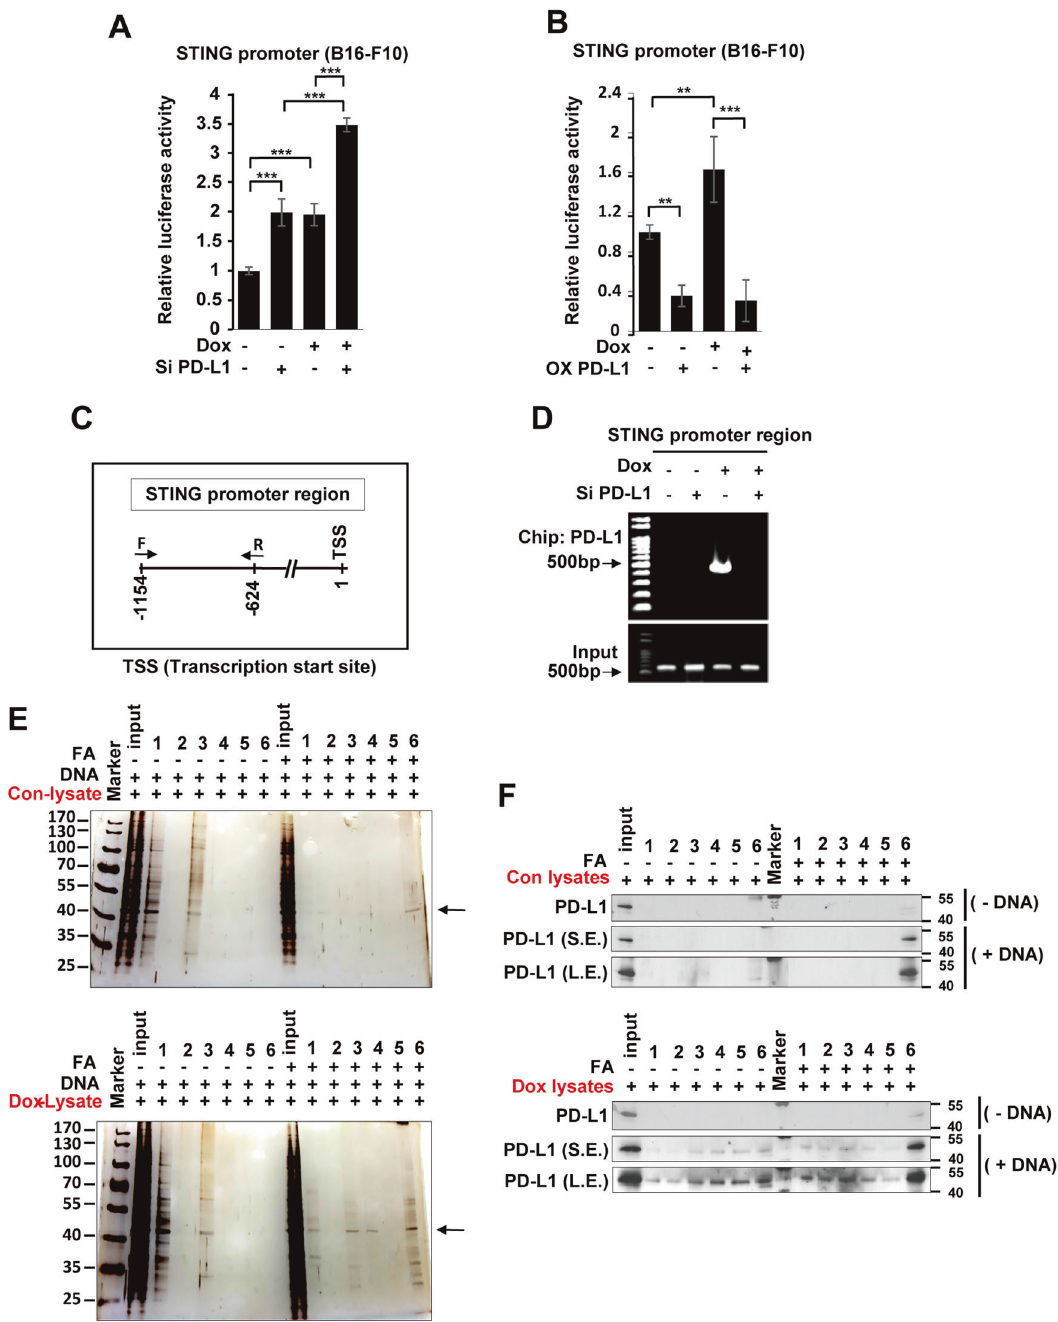
Fig. 5 PD-L1 modulates STING transcription. B16-F10 cells were transfected with the STING promoter harboring plasmid prior to siRNA treatment or PD-L1 overexpression. Then, cells were treated with 100 ng/mL Dox and a luciferase assay for STING promoter activity was performed on day 3 post-treatment ( A , B ). Additionally, B16-F10 cells were transfected with 100 nM control (siC) or PD-L1 (siPD-L1) siRNA prior to treatment with 100 ng/mL Dox, and an immunoprecipitation assay (ChIP) was performed with an anti-PD-L1 antibody. PCR was performed using the indicated STING promoter-speci fi c primers for ChIP assays ( C , D ). For the DNA pull-down assay, speci fi c PD-L1 bands bound to the STING promoter DNA (from − 1154 to − 624 bp) were eluted with the indicated washing buffer (1:150 mM NaCl-1st washing; 2: 150 mM NaCl- 2nd washing; 3: 250 mM NaCl-1st washing; 4: 250 mM NaCl-2nd washing; 5: 500 mM NaCl-1st washing; 6:500 mM NaCl-2nd washing). Finally, the results were analyzed by silver staining and western blotting, respectively ( E , F ). Arrows indicate the PD-L1 protein. FA: formaldehyde, S.E. short exposure, L.E. long exposure. The signi fi cance of the statistical difference among the three groups was calculated using a one-way analysis of variance and Newman-Keuls. Quantitative data are expressed as the mean ± SD . ** p < 0.01, *** p < 0.001. contribute to full tumor regression. Our fi nding can be supported cancer cells. In contrast to the previous reports on the role of cell by the previous report that PD-L1 can directly regulate gene membrane PD-L1 in immune function, we elucidated the pivotal expression at the transcription level. For example, PD-L1 directly role of nuclear PD-L1 in cancer regulation, which suggests that regulates the expression of embryonic stem-cell transcription targeting nuclear PD-L1-induced senescence via STING can